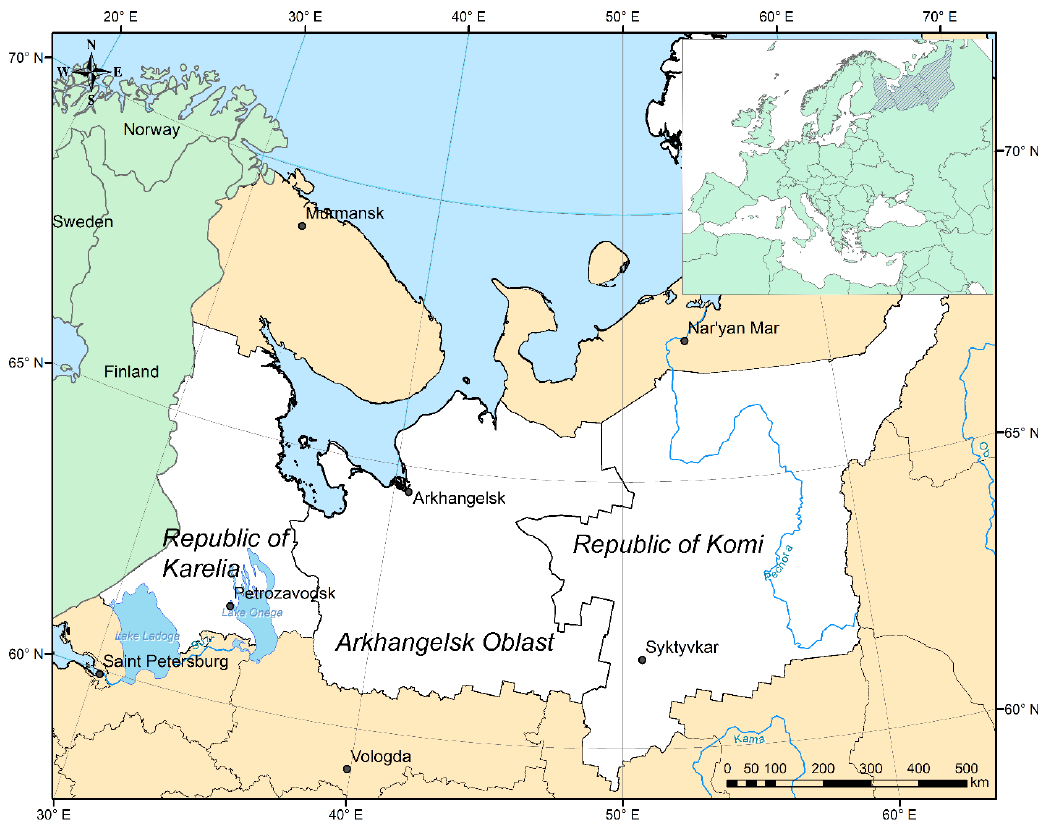
Figure 1. Geographical location of the Arkhangelsk region, the Republic of Karelia and the Komi Republic in the north of European Russia.